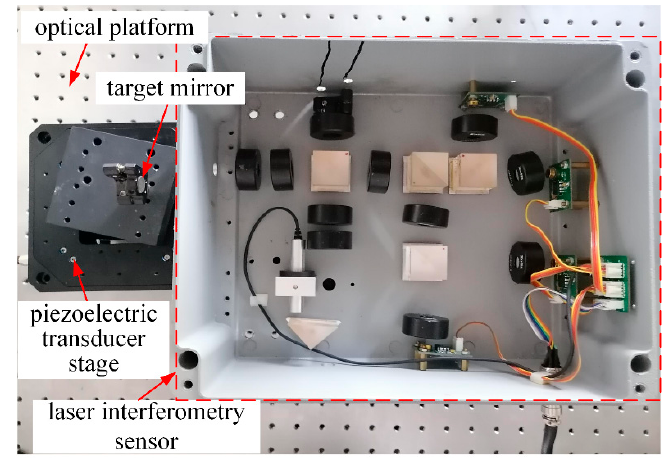
Figure 4. Experimental setup for resolution and stability test.